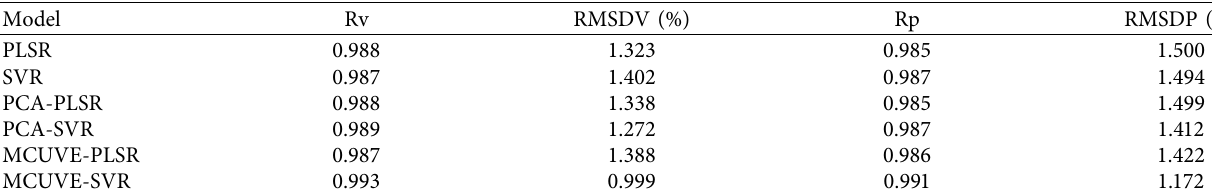
Figure 6: The stability of the data processed by MCUVE. Table 1: Performance of the